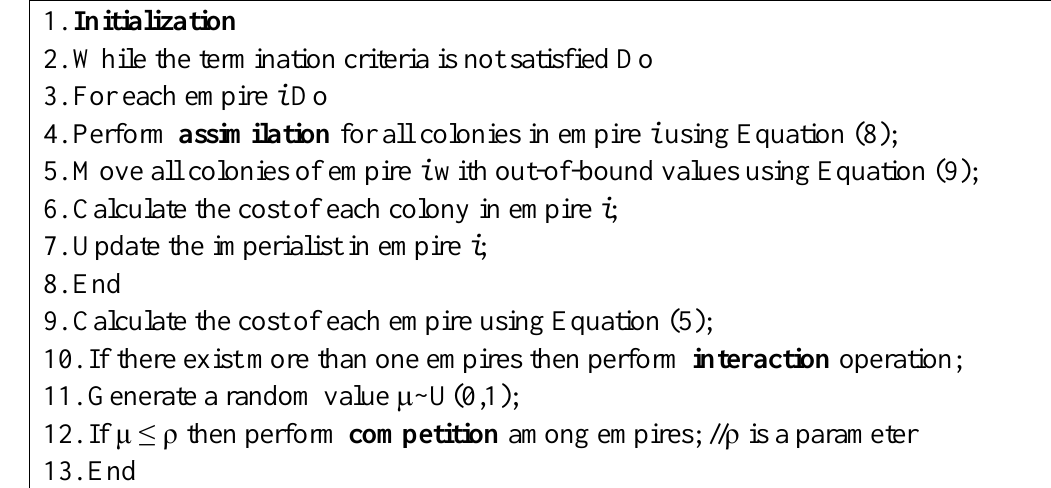
Figure 2. Interaction Enhanced